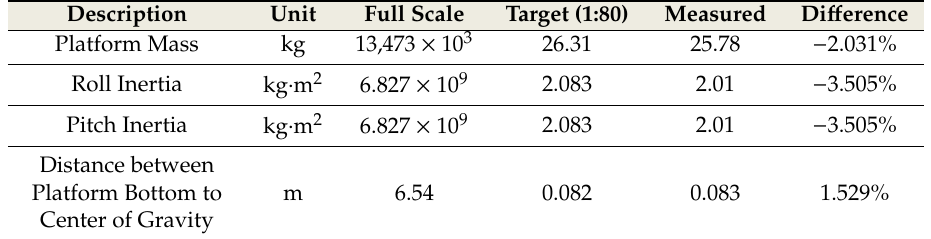
Table 2. Comparison between measuring and target properties of the platform scaled model.